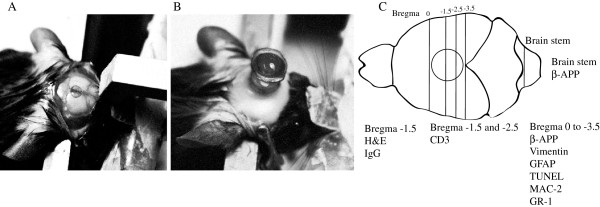
Central fluid percussion injury (cFPI) procedure. (A) To prepare for cFPI, a 3.0 mm diameter craniotomy was made in the midline between the bregma and lambda sutures, leaving the underlying dura intact; (B) Using dental cement, a cap filled with normal saline was sealed over the craniotomy; (C) Overview of the bregma levels where the different immunohistochemical analyses were prepared.